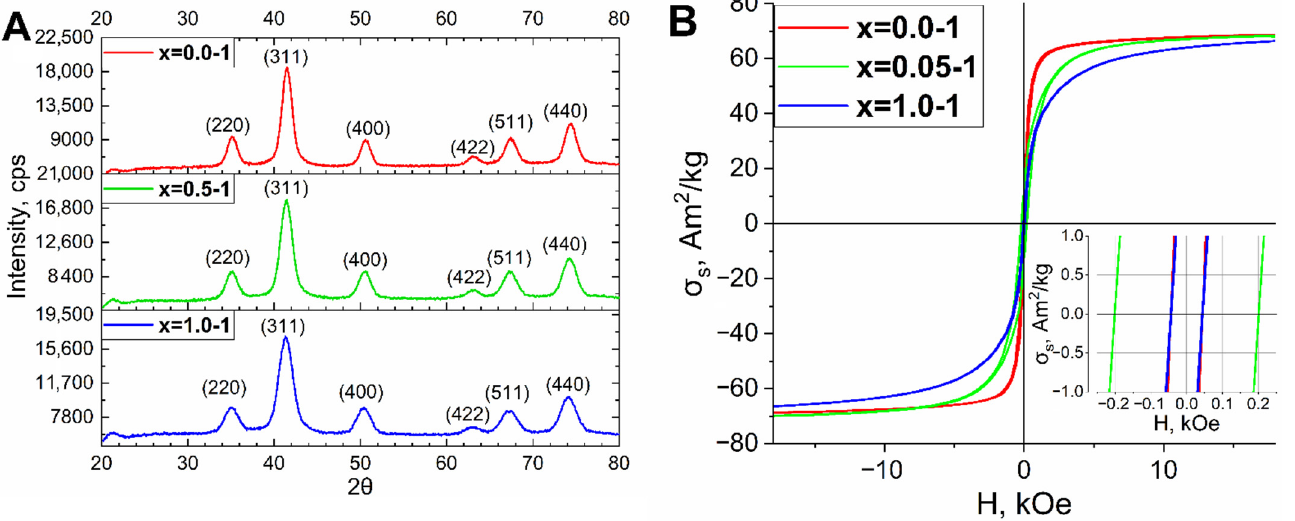
All the synthesized samples x = 0.0-1, x = 0.5-1, and x = 1.0-1 were further used for the synthesis of the Co x Fe 3 − x O 4 -BaTiO 3